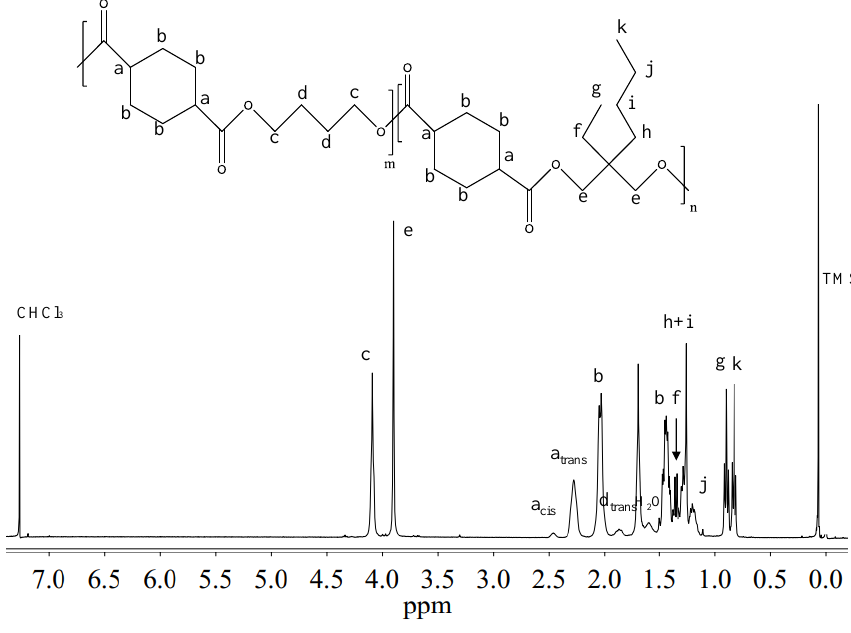
Figure 2. 1 H-NMR spectrum of P(BCE 65 BEPCE 35 ) with resonance assignments.